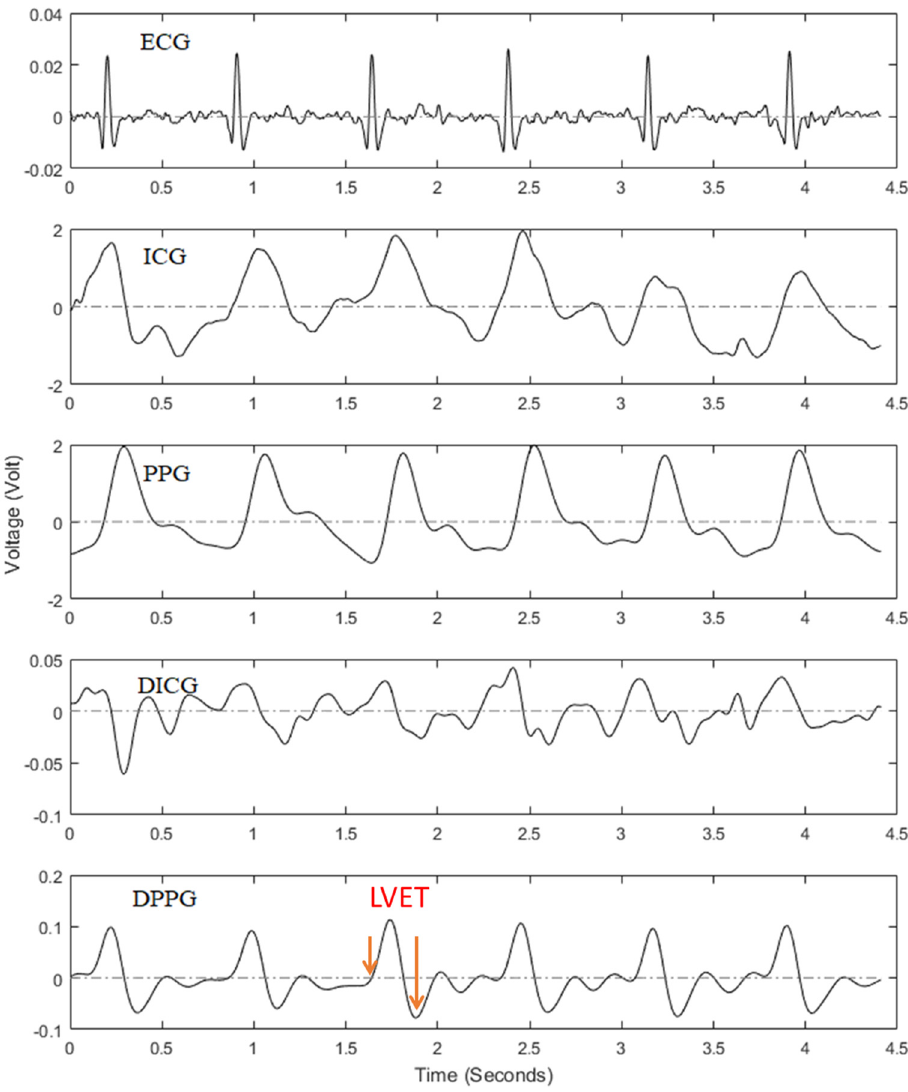
Figure 3. Typical signal registration in the study. From the first row to the fifth row are the electrocardiogram (ECG), impedance cardiography (ICG), photoplethysmography (PPG), differential ICG (DICG), and differential PPG (DPPG), respectively. The left ventricular ejection time (LVET) is defined as the time interval between the first zero crossing point (short arrow) and the minimum point (long arrow) in the DPPG signal.